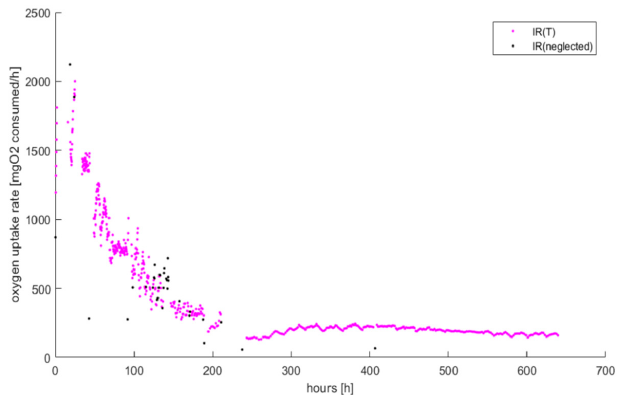
Figure A2. All the cycles calculated with the function fitlm in Matlab ® are shown. Quality assessment of the oxygen consumption rate of the cycles for MIX 25%: in black the dots with R 2 < 0.95 to reject. Table A1. Quality assessment of the oxygen consumption rates: the data for each cycle were rejected if R 2 < 0.95. # Neglected (R 2 < 0.95)